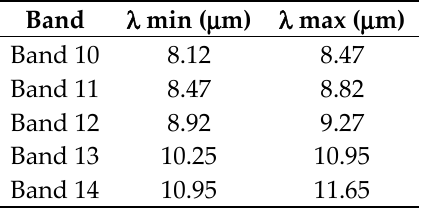
Figure 2. ASTER acquisition over Fucino area, Abruzzo, Italy: ( a ) ASTER A09 product—Ground emitted radiance image at 10.657 μ m, ( b ) ASTER A08 product—Temperature image. Table 2. ASTER TIR spectral